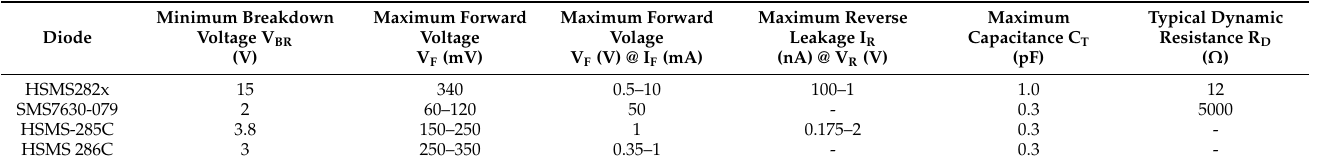
Table 3. Schottky diodes.